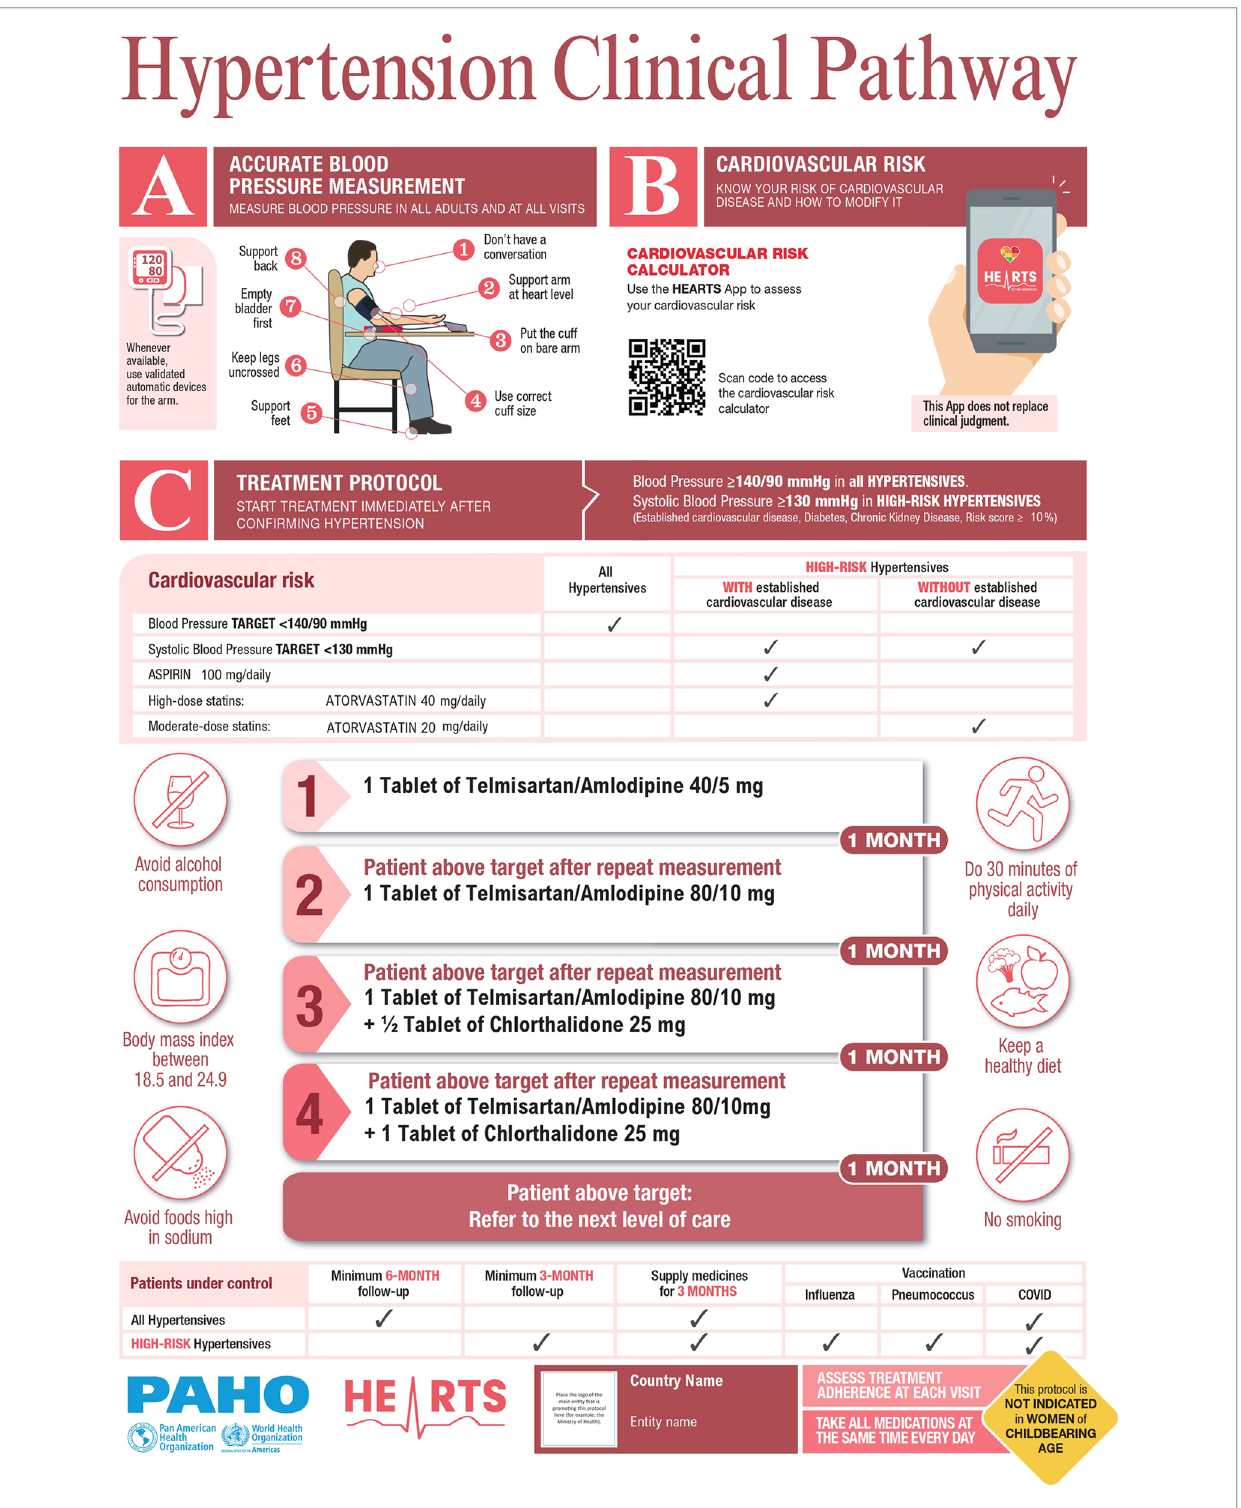
FIGURE 1 HEARTS in the americas hypertension clinical pathway*. *The medications serve as examples and can be replaced with any two medications from any of the three drug classes (ACEis/ARBs, CCBs or thiazide/thiazide-like diuretics). Start with a single-pill combination ( fi xed-dose combination) or two individual pills if FDC is not available. Figure was prepared by authors. See Ref